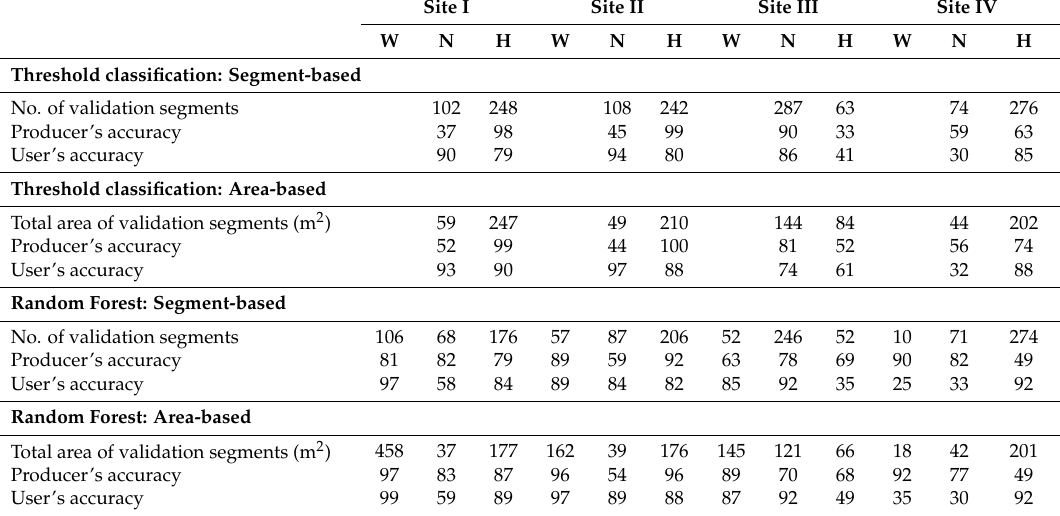
Table 6. Producer’s and User’s accuracy (%) of the growth forms nymphaeid (N) and helophyte (H) using a threshold classification and of water (W), nymphaeid, and helophyte using Random Forest. Site I Site II Site